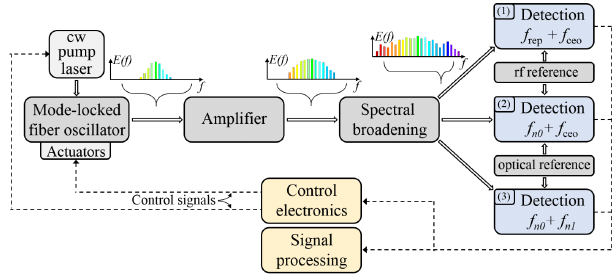
Figure 2: Block diagram of a typical fiber laser-based frequency comb system. The pulsed output of a fiber laser oscillator is am- plified and spectrally broadened. These pulses are then launched into a highly nonlinear fiber in which nonlinear processes such as self-phase modulation, self-steepening, four-wave mixing, and Ra- man scattering spectrally broaden the pulses to a full octave. The detected signals are used in a control loop for the stabilization or they are combined with the experimental signals appropriately in signal processing to cancel out the comb noise. f n 0 : frequency of a single optical comb tooth compared to an optical reference, f n 1 : fre- quency of a single optical comb tooth compared to another optical